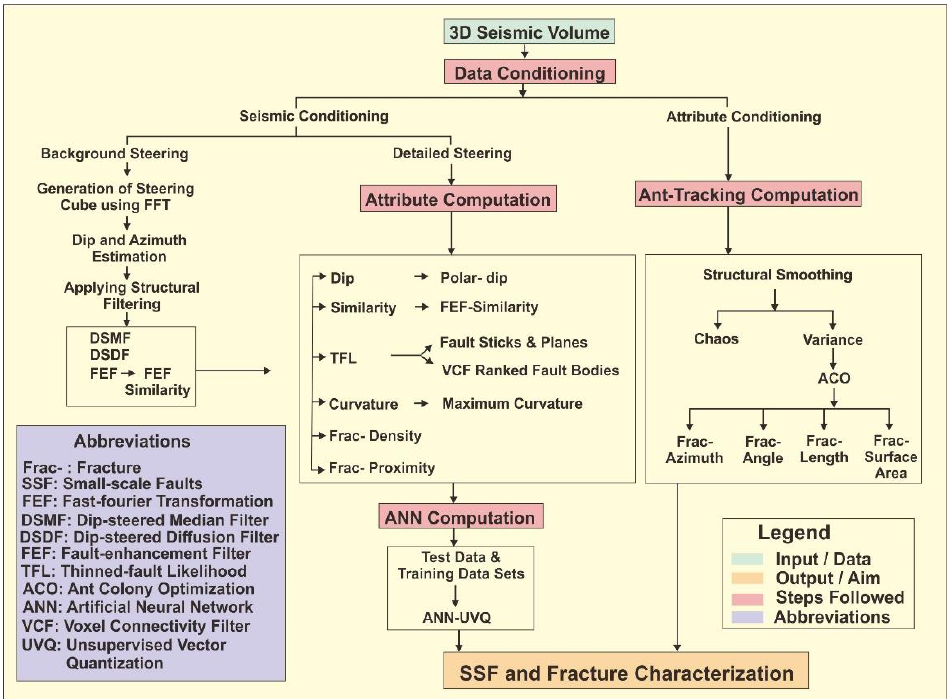
Figure 2. The workflow implemented for the current study comprised four steps; the first was data-conditioning, the second was the selection of attribute computation, the third was artificial neural network (ANN) computation, and the fourth was ant colony optimization (ACO) computation.